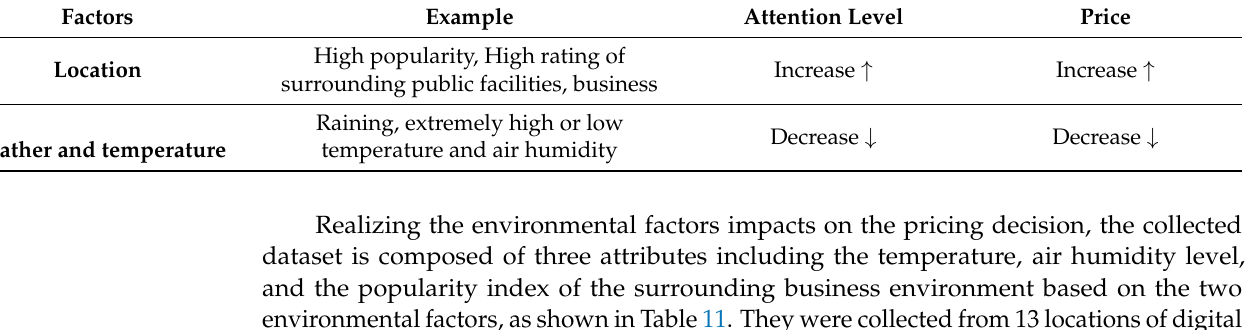
Table 11. Environmental factors and its impact on the attention level and pricing of DSA. Factors Example